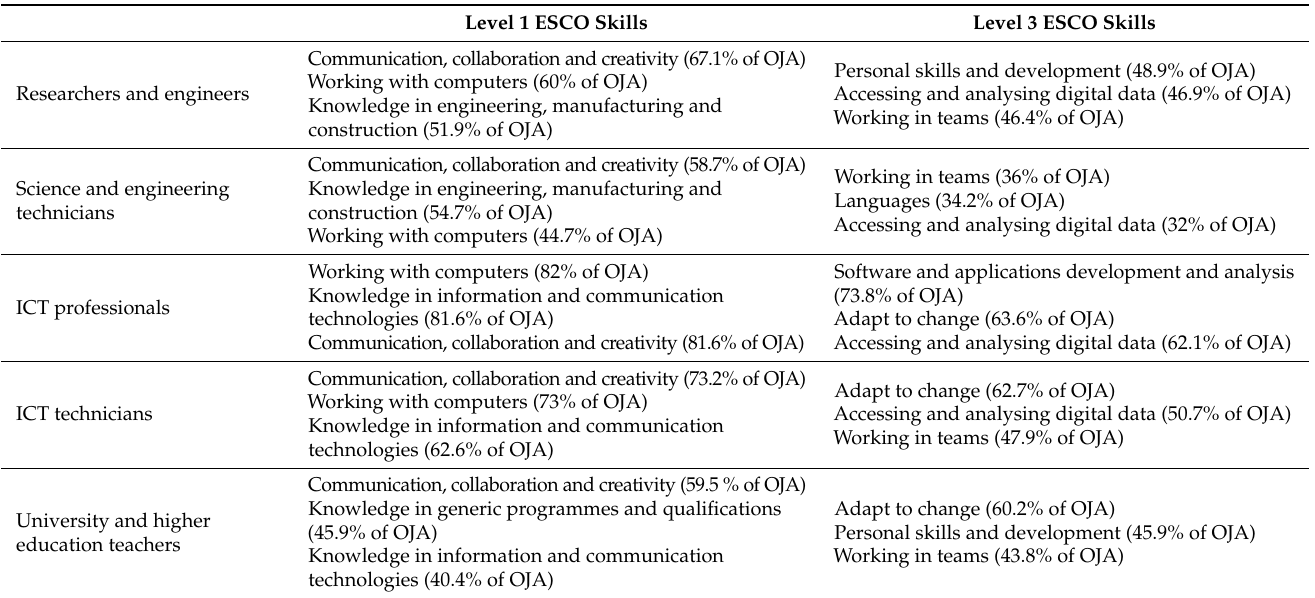
Table 3. Top three skills requested in knowledge production and transfer